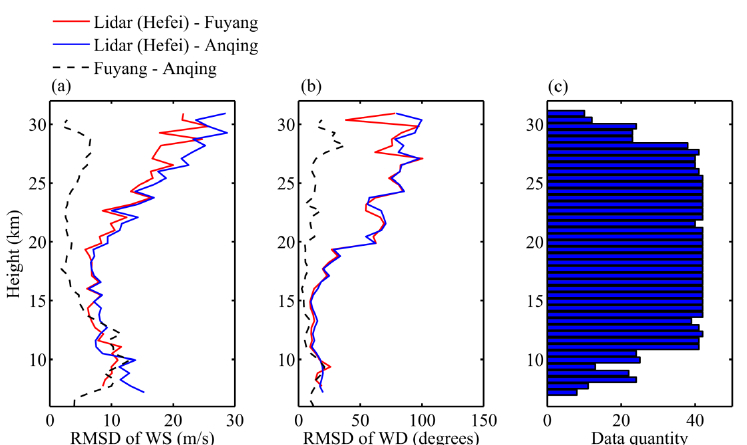
Figure 10. RMSD profiles of ( a ) wind speeds and ( b ) wind directions between different locations: lidar — Fuyang (red lines), lidar — Anqing (blue lines), and Fuyang — Anqing (black dashed lines); ( c ) data quantities at different heights.